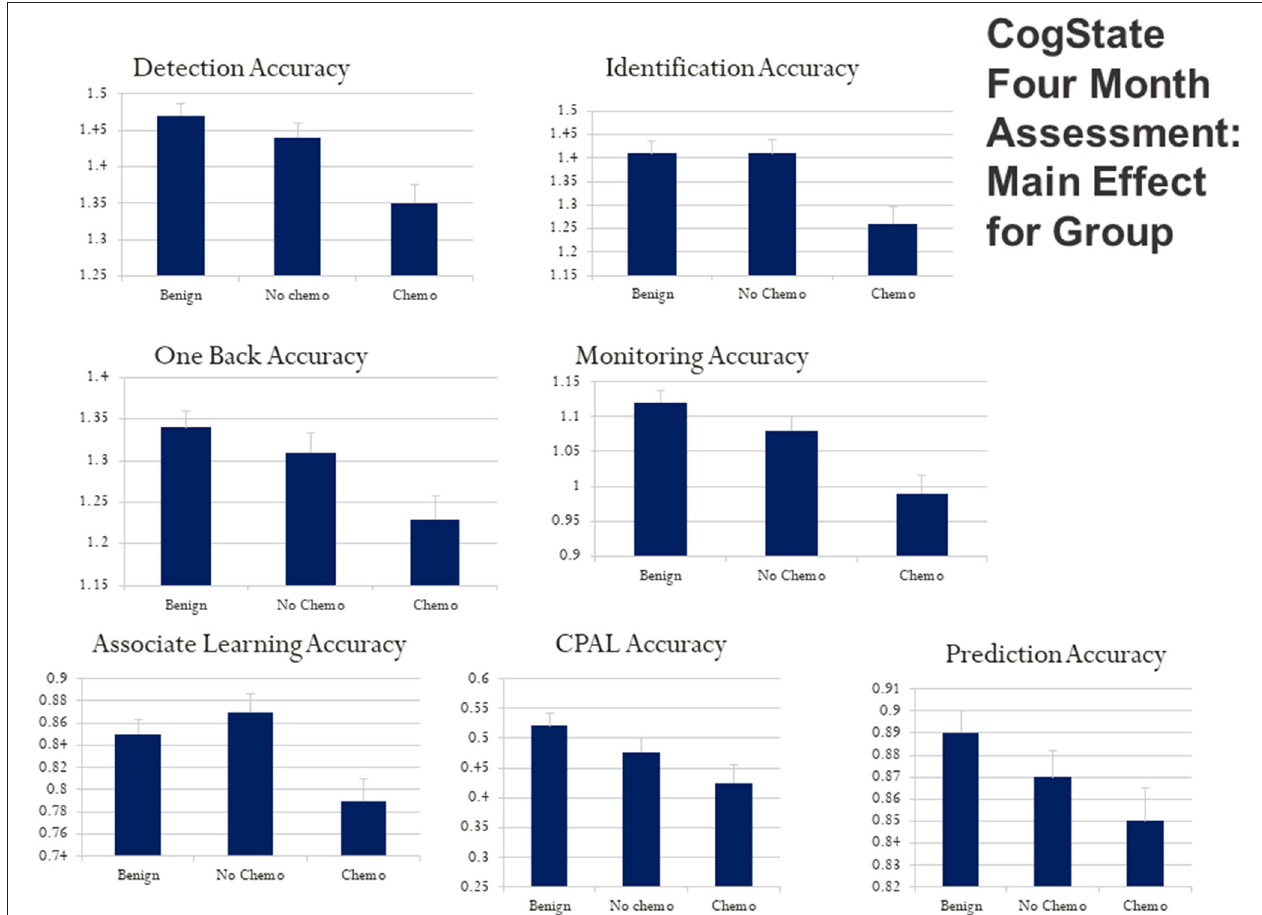
FIGURE 4 | CogState computerized cognitive ability test score box plots for the benign (breast lump autopsy), no-chemo (treatment for breast cancer), and chemo (treatment for breast cancer) groups. Higher scores mean better cognitive performance on the battery of tests with playing cards. Box plots are presented for card detection accuracy, card identification accuracy, one-back card memory accuracy, card monitoring (prior card recognition learning) accuracy, card paired-associate learning accuracy, continuous paired-associate learning accuracy (CPAL), and card presentation pattern prediction accuracy. The SE value for each group is capped above its